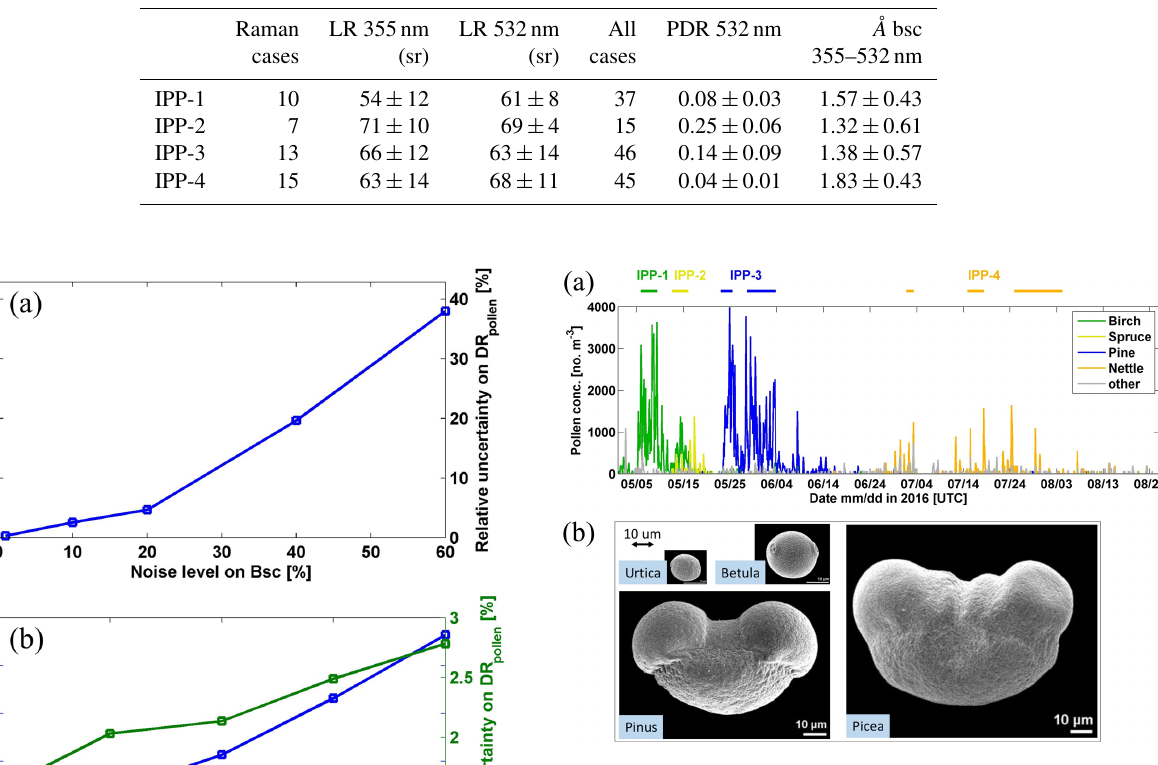
Figure 8. (a) Pollen concentration (2h average) measured by the Burkard sampler at roof level. The main pollen types are shown according to the colour code. Defined intense pollination periods (IPPs) are shown by lines on the top. (b) Microphotographs of pollen grain: Urtica (nettle pollen), Betula pendula (birch pollen), Pinus (pine pollen), Picea abies (spruce pollen). Source: PalDat – a palynological database (https://www.paldat.org, last